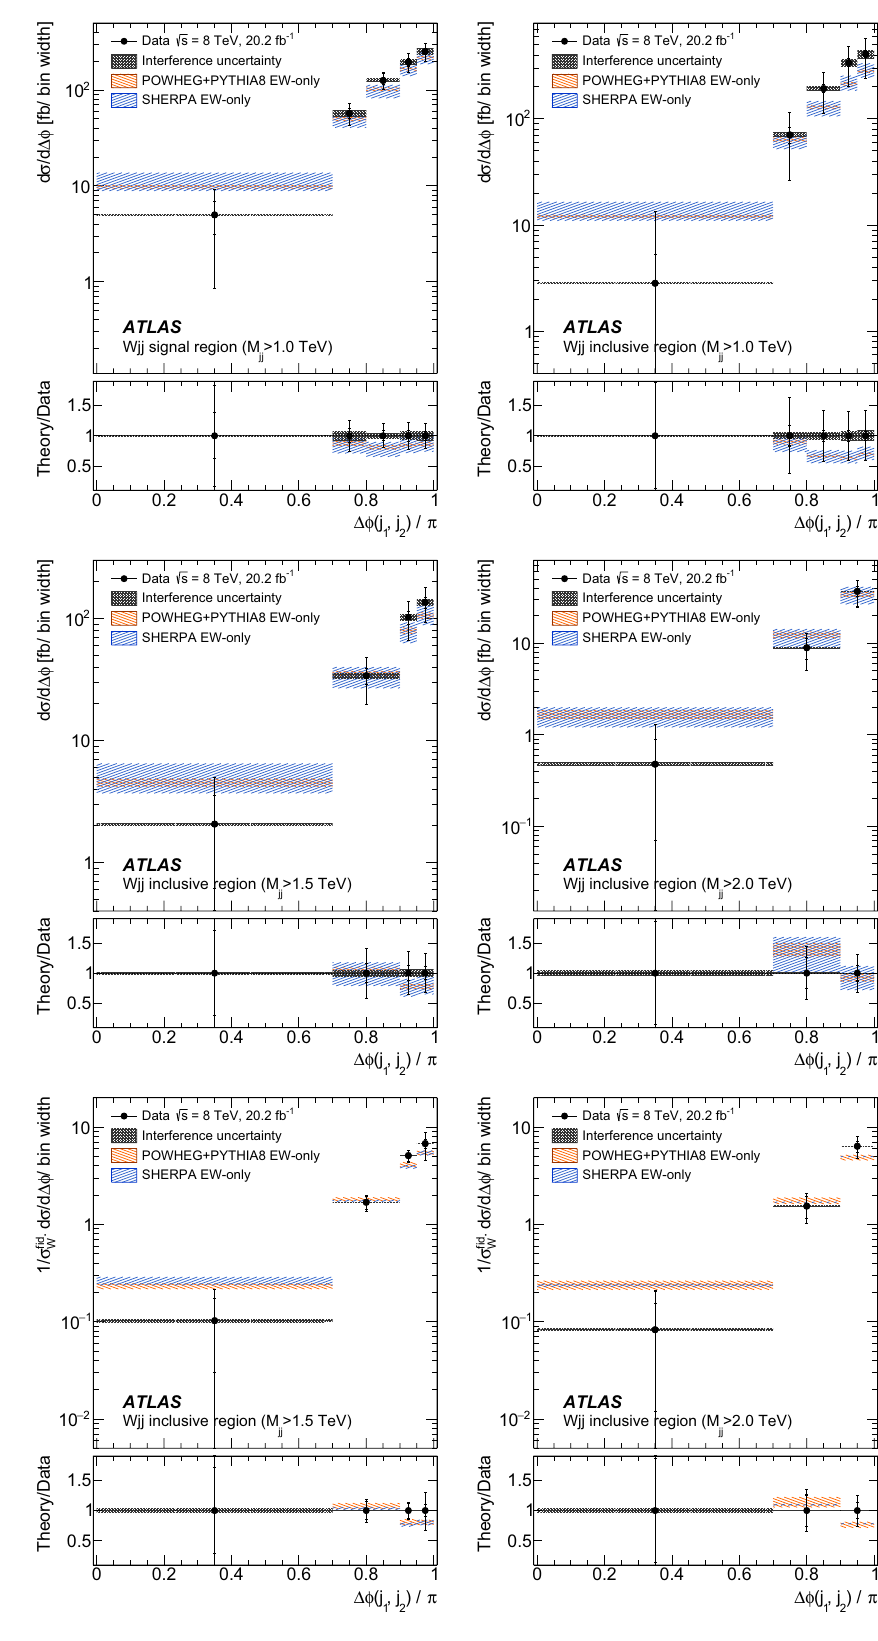
Fig. 52 Differential electroweak W jj production cross sections as a function of (cid:6)φ( j , j ) in the high-mass 1 2 signal region and the inclusive fiducial region with three thresholds on the dijet invariant mass (1.0, 1.5, and 2.0 TeV). The bottom two distributions are normalized, the rest are absolute. Both statistical ( inner bar ) and total ( outer bar ) measurement uncertainties are shown, as well as ratios of the theoretical predictions to the data (the bottom panel in each